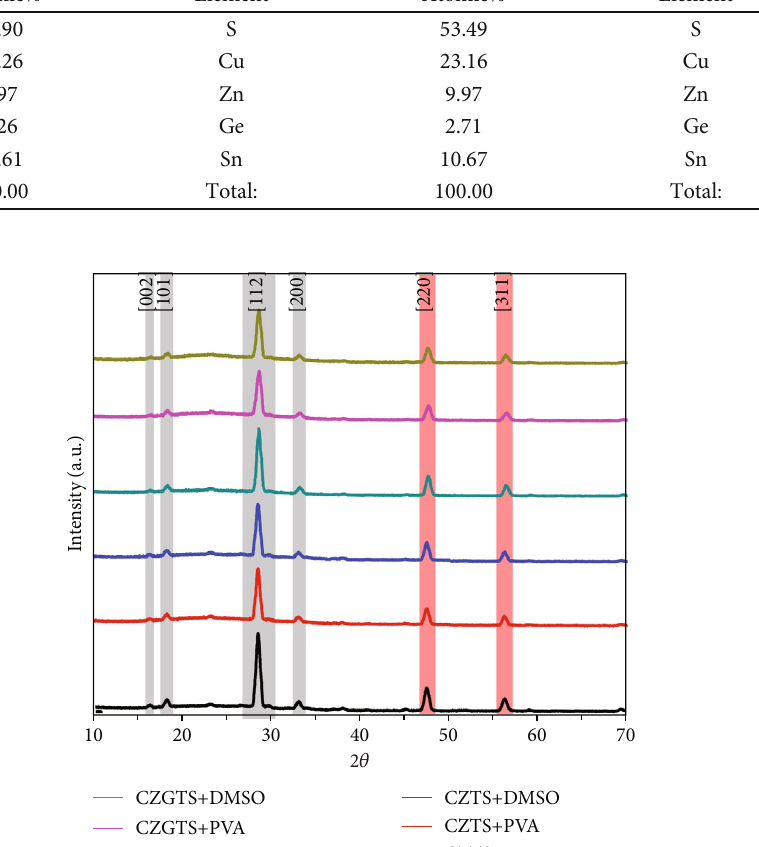
Table 2: EDS analysis obtained alloying element average concentration for the CZGTS, CZGTS-PVA, and CZGTS-DMSO doctor-coated thin fi lms. CZGTS-PVA CZGTS-DMSO